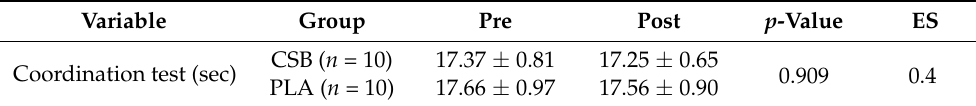
Values are Mean ± SD. ES: effect size, CSB: combined creatine and sodium bicarbonate supplementation group, PLA: placebo group; ** Interaction effect between group and time ( p < 0.01); tested by analysis of variance (ANOVA) with repeated measures. Table 3. Change of coordination test following combined creatine and sodium bicarbonate supplementation.